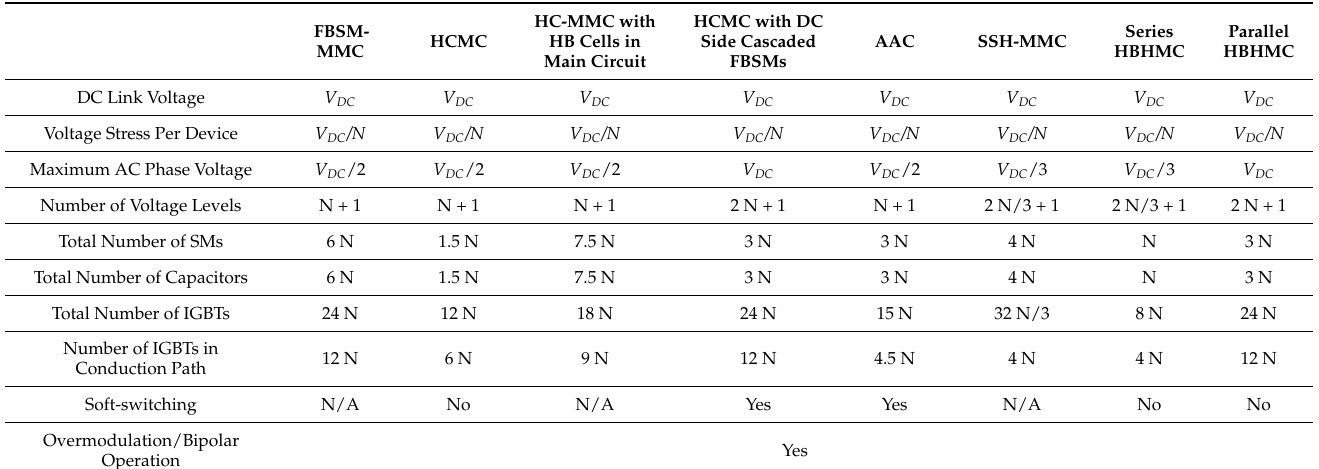
Table 4. Comparison Among Hybrid MMC Configurations.